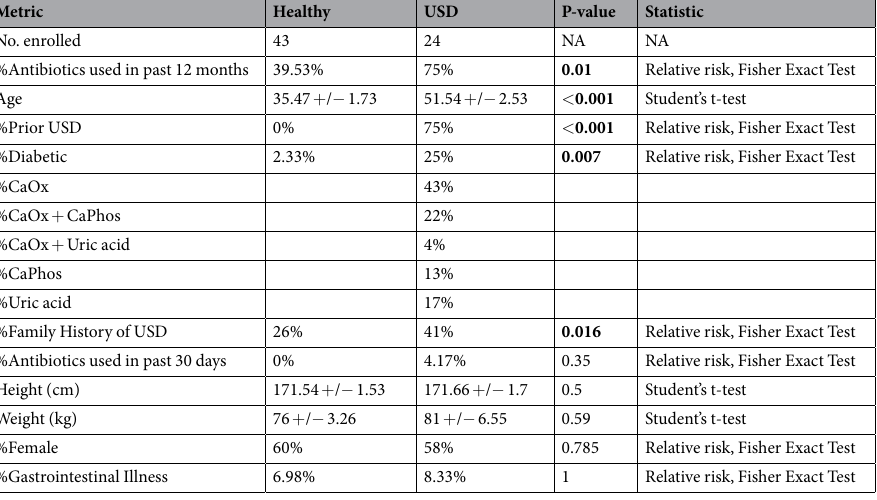
Table 1. Patient metadata. P-values for significantly different metrics are bolded. * Values expressed as mean + / − standard